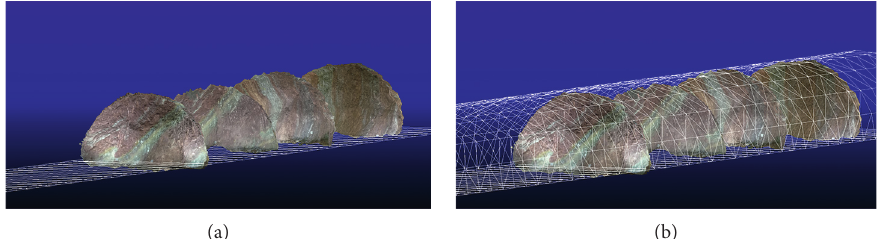
Figure 14: (a) The results of 3D reconstruction in Fengjie railway tunnel in Chongqing. (b) 3D geological model arranged according to the design of the rail line.